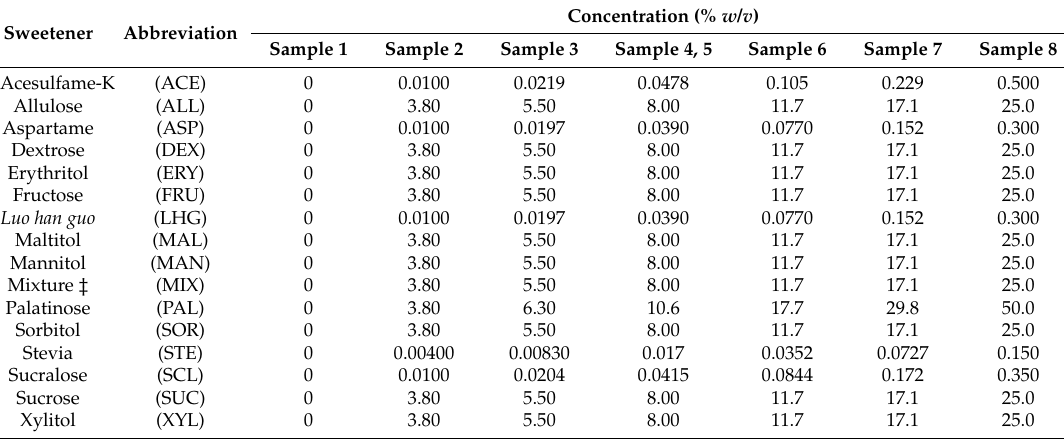
Table 2. Concentrations tested for each of the sweetener set by weight basis (% w / v ).